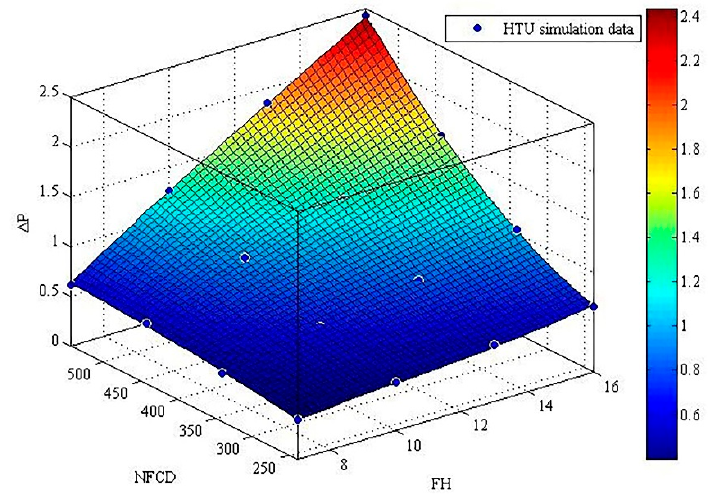
Figure 14. Fitting surface for air-side pressure drop of AR ( Δ P ).